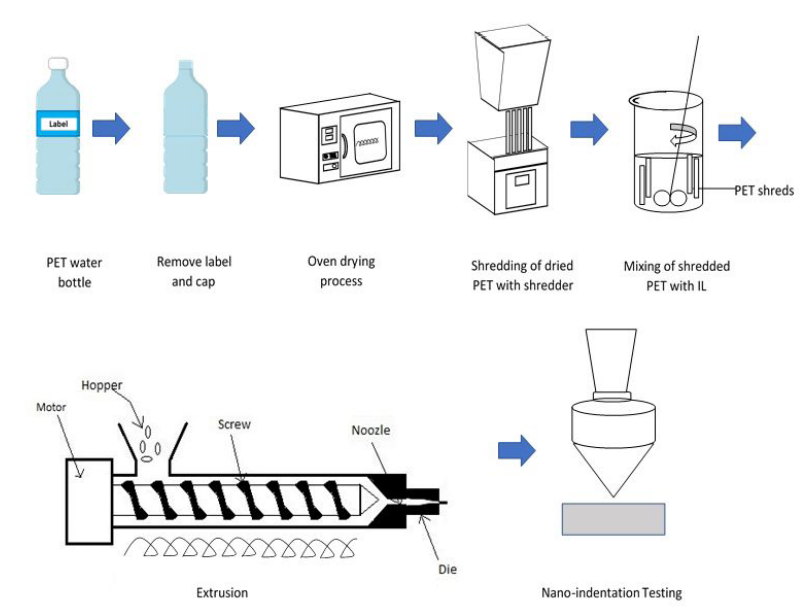
Figure 3. Process Schematic.